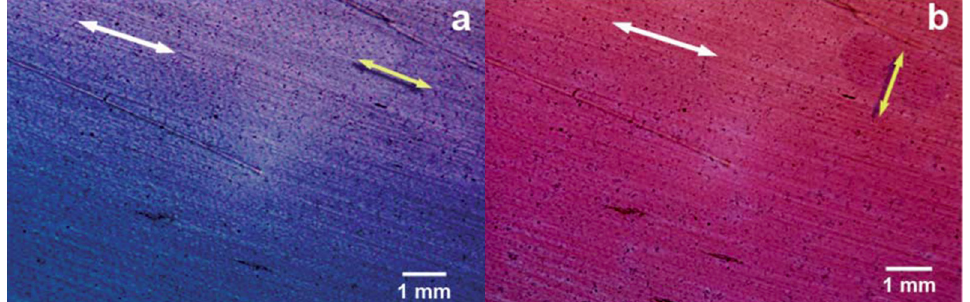
Figure 20. Optical microscopy images of oriented Au/EVAl44 oriented film (Dr = 5) with polarization direction of the incident light parallel ( a ) and perpendicular ( b ) to the drawing direction. The white arrows denote the stretching direction of the film, whereas the yellow ones indicate the direction of the electric vector of polarized light. Reproduced from Pucci [129] with permission of The Royal Society of Chemistry.